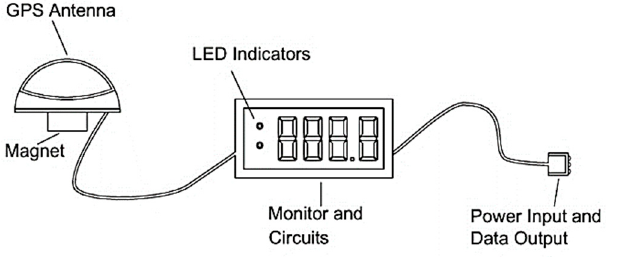
Figure 1. A schematic view of a commercially-available low-cost GPS speed